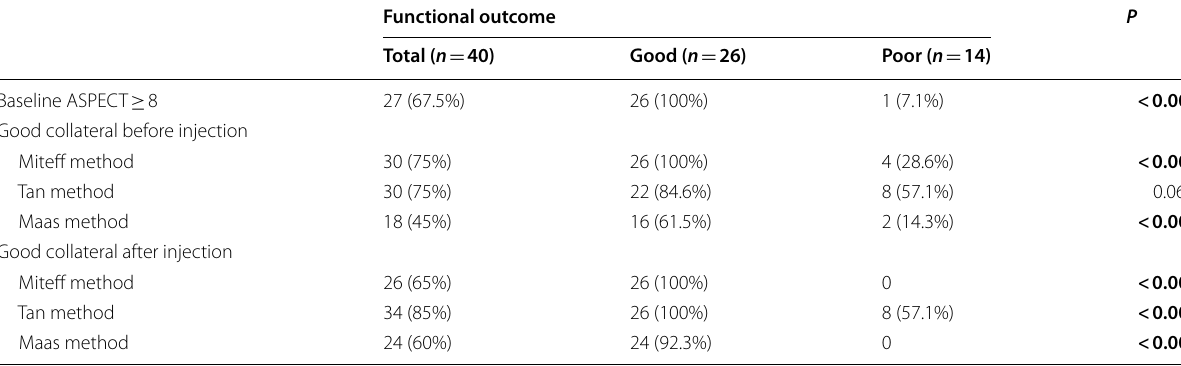
Data expressed as frequency (percentage). P value was significant if < 0.05. n : number; CTA computed tomography